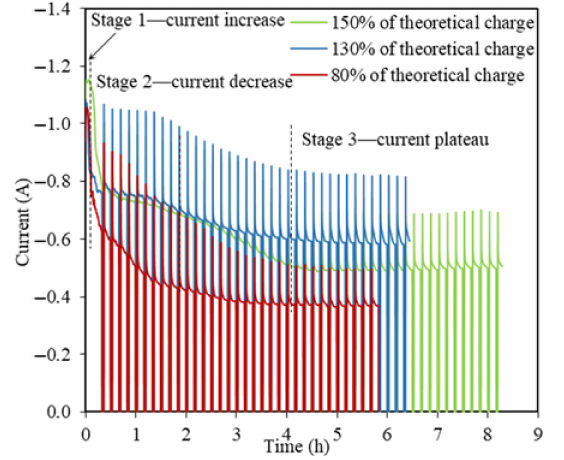
Figure 5. Current–time profiles for the TiO 2 reductions at − 0.3 V vs. Li/Li + using 80%, 130%, and 150% of the theoretical charge for 2 g TiO 2.